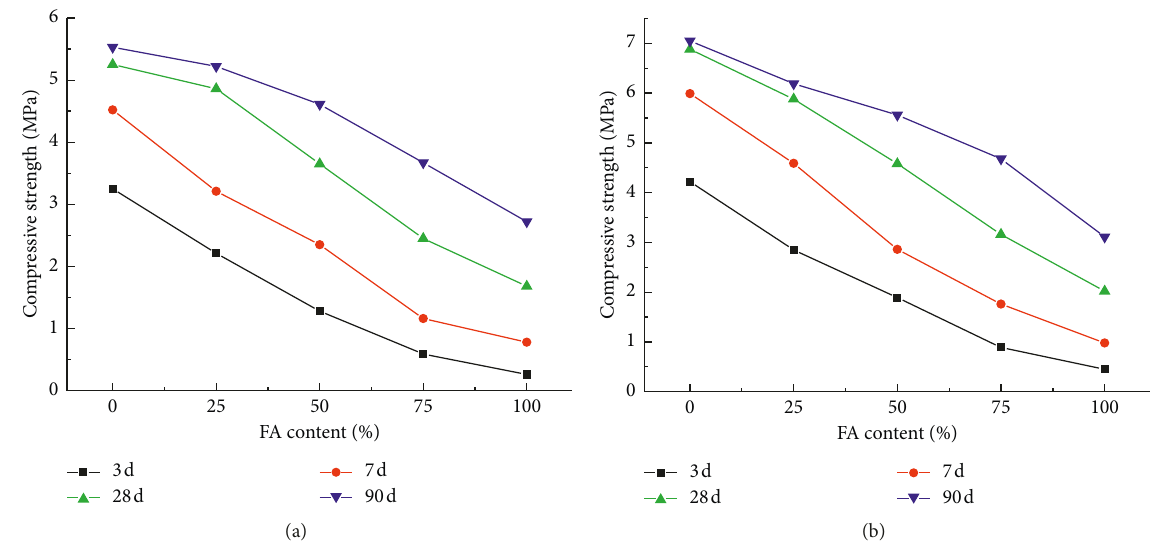
Figure 5: Compressive strength of BM samples: (a) 8N; (b)